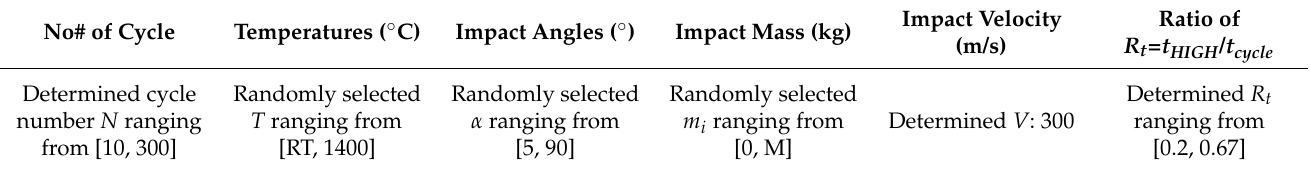
Table 9. Parameters used to calculate erosion rates at selected high-temperature dwell